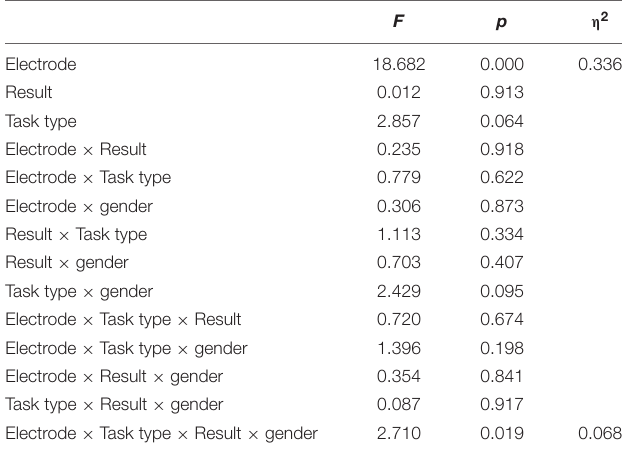
TABLE 1 | Results of FRN Analysis.